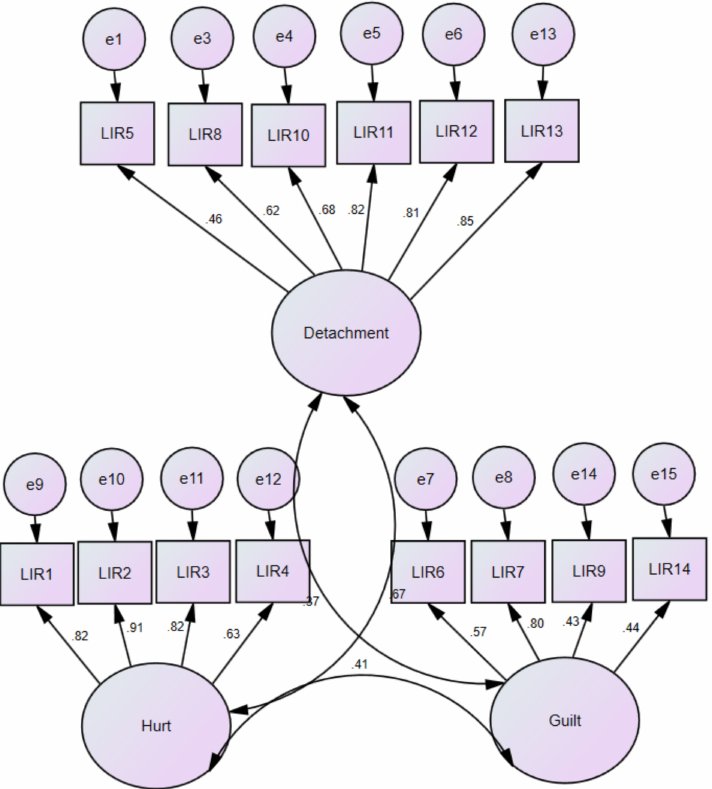
Figure 1. Standardized coefficients for the LIRS final version three-factor model—Study